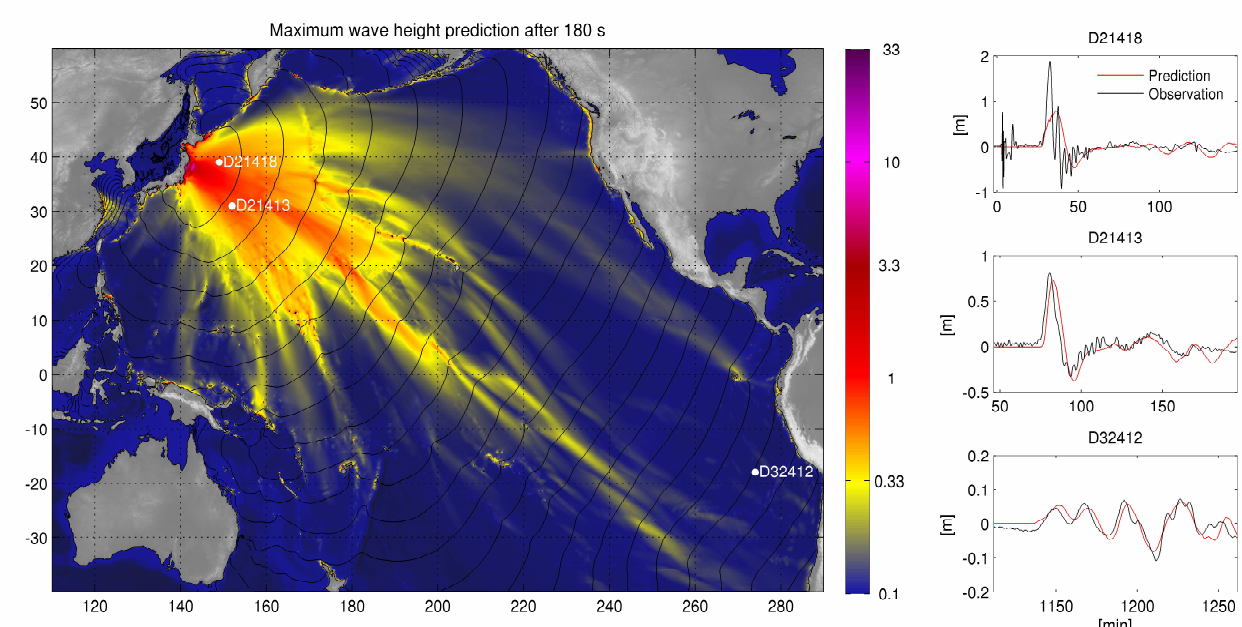
Fig. 3. Left panel: Maximum wave heights in the Pacific predicted by the model inverted after 180s. Thin black lines are isochrones in 1h intervals. White dots denote positions of the buoys for which model and observation are shown in the right